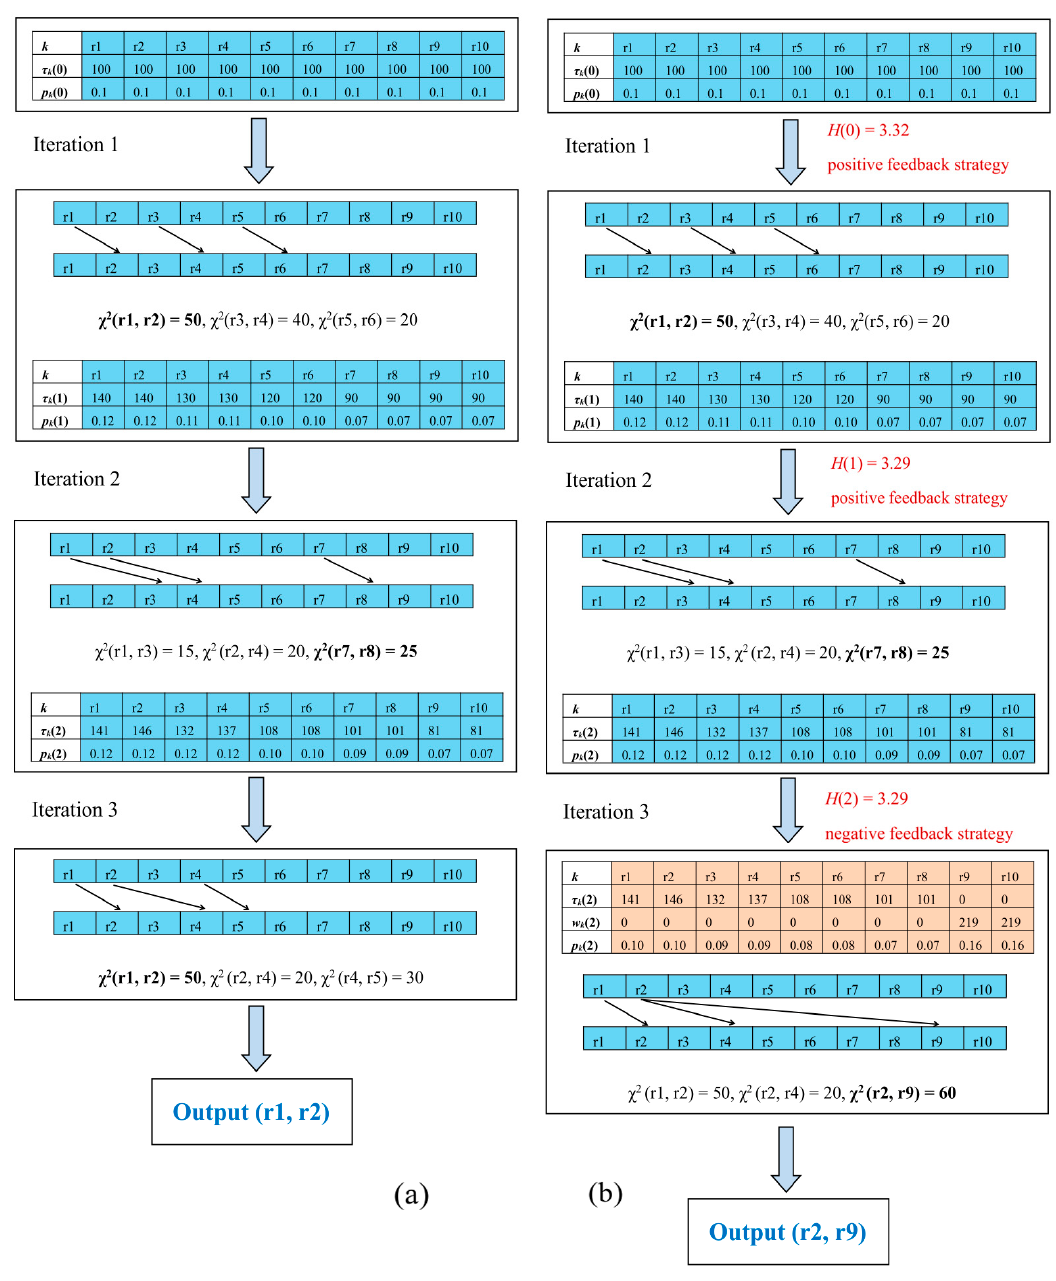
Figure 2. ( a ) The process of searching for interactions by using ant colony optimization (ACO); ( b ) the process of searching for interactions using IEACO.